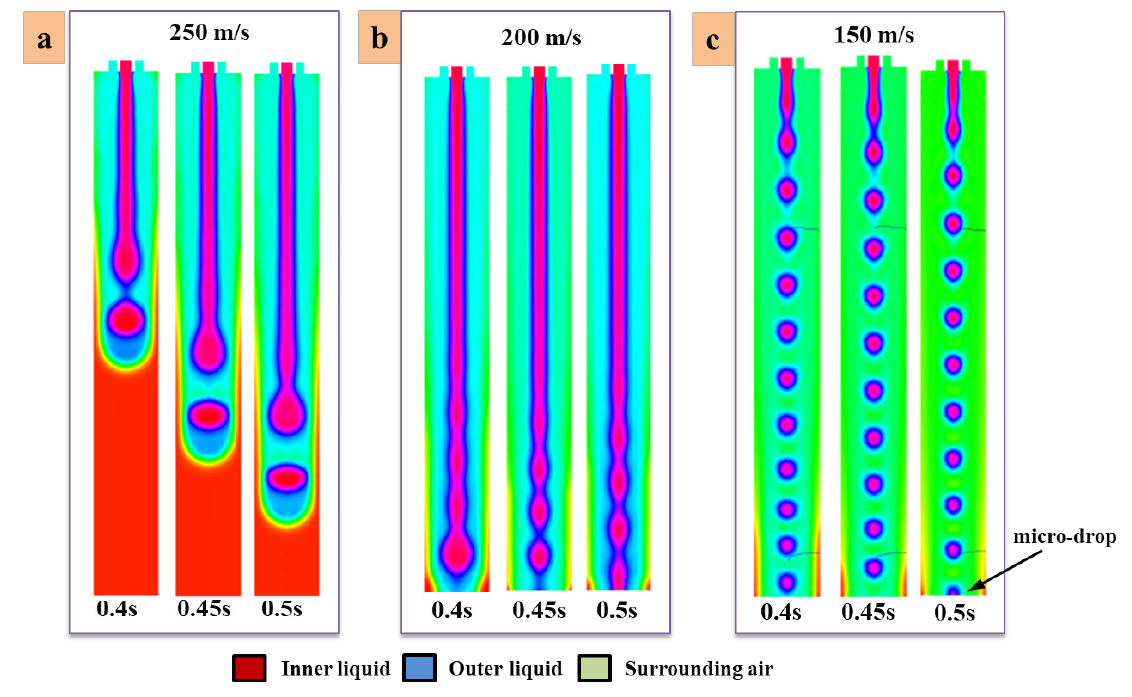
Figure 7. The formation of bilayer microdroplets during stable micro-dripping mode at different time intervals under different values of inner flow velocities ( a ) 250 m/s, ( b ) 200 m/s, and ( c ) 150 m/s.